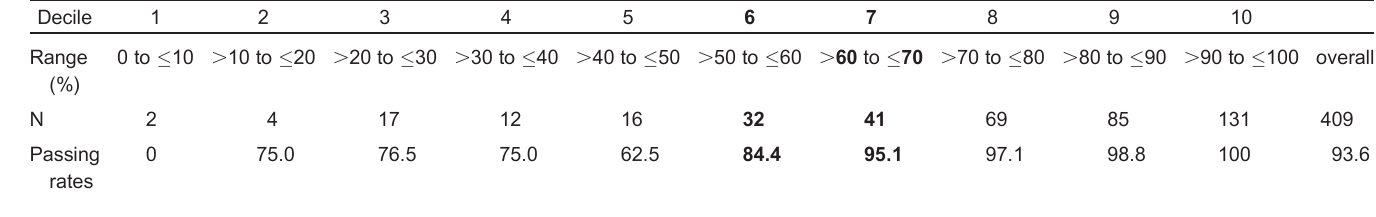
Table 5. The American Osteopathic Board of Emergency Medicine (ABOEM) passing rate for each decile on the Resident In-Service Examination (RISE). The greatest change in association between RISE percentile and ABOEM pass rate occurred from the 50 th to 70 th